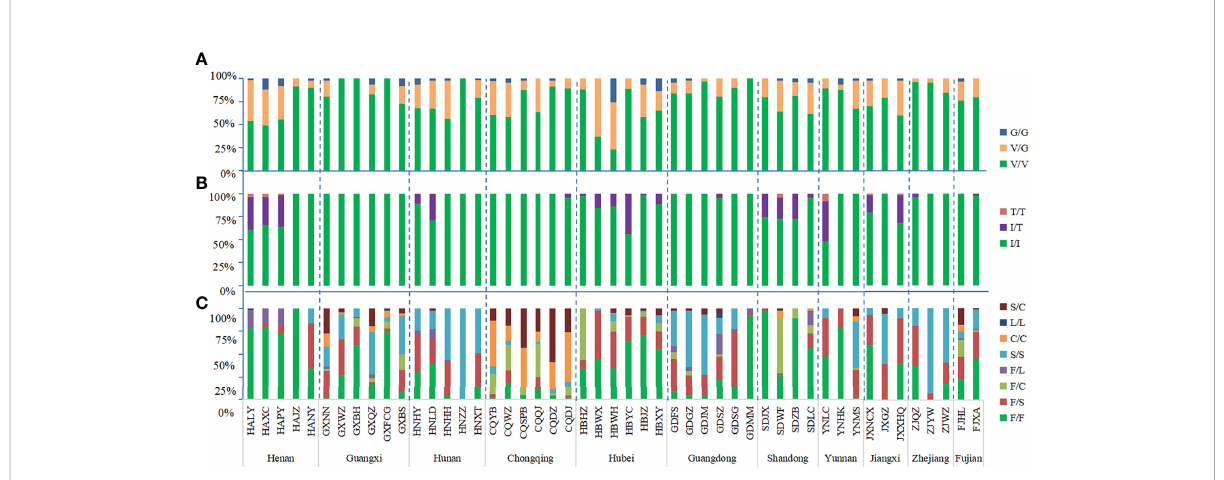
FIGURE 3 Histogram of genotype frequency at codons 1016 (A) , 1532 (B) and 1534 (C) of the the VGSC in Ae. albopictus populations. The dotted line separates the sites by each province. The horizontal axis indicates the populations (see Table 1 and Figure 1 for detail), while the vertical axis denotes the genotype